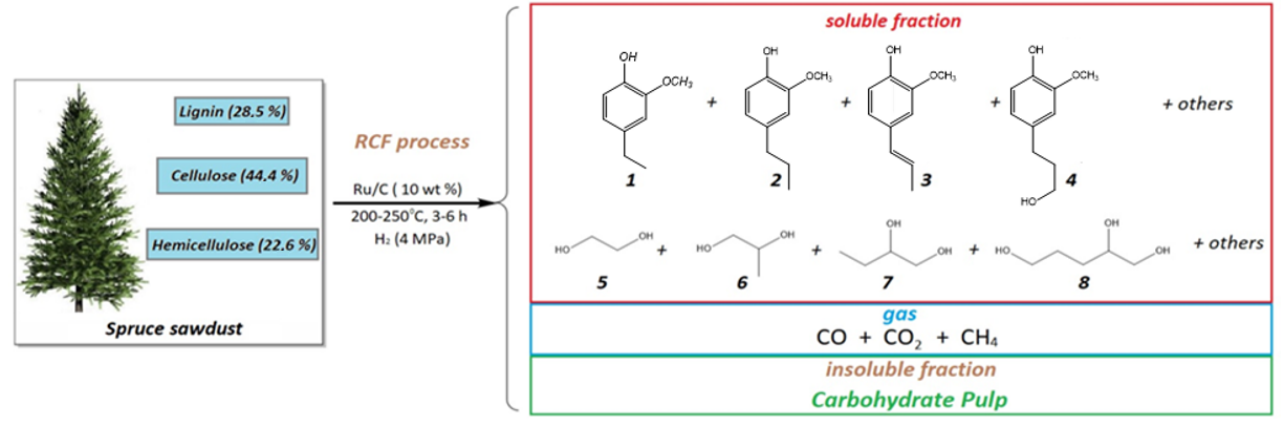
Figure 16. The main products of the reductive catalytic fractionation of spruce wood.